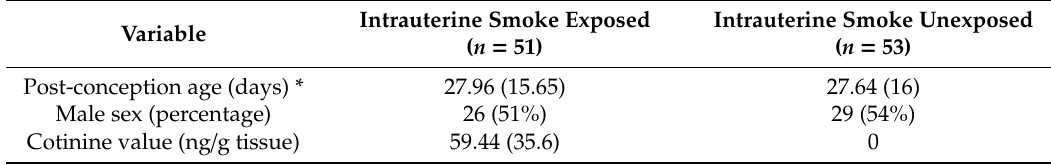
Table 1. Baseline characteristics for the human fetal lung tissue samples utilized in these analyses.